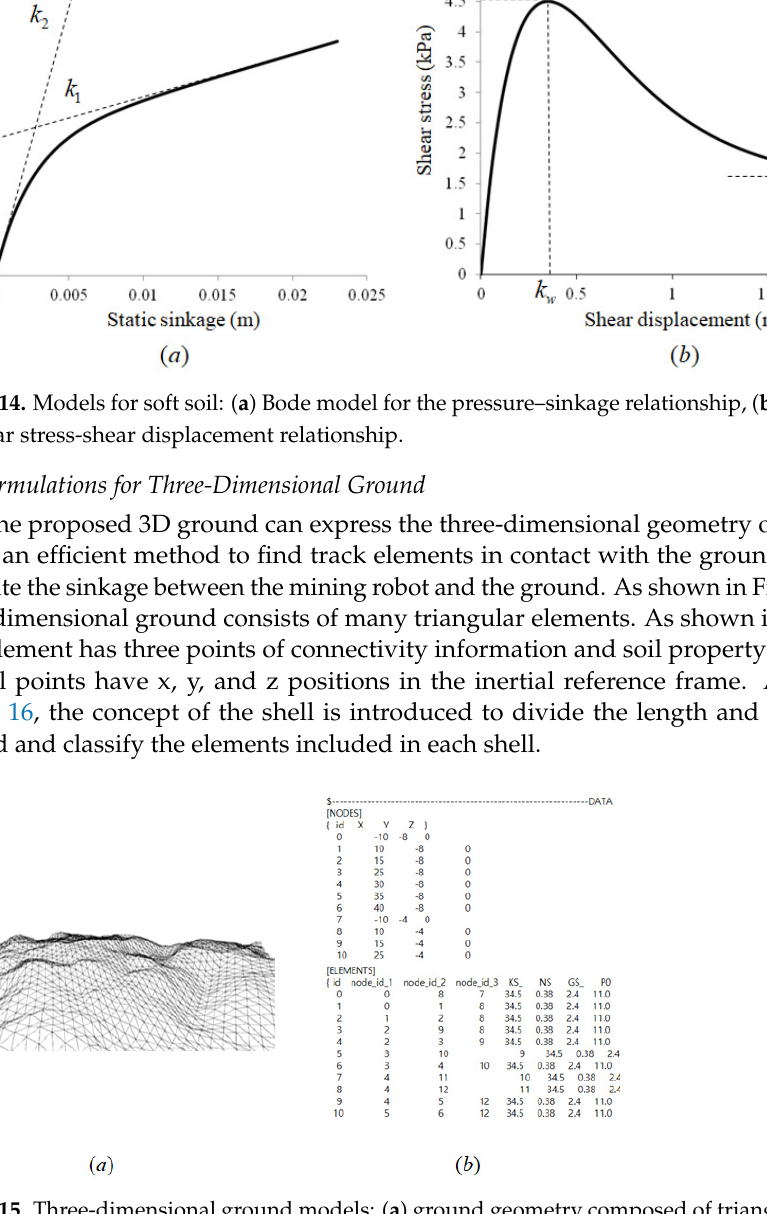
Figure 15. Three-dimensional ground models: ( a ) ground geometry composed of triangular elements, ( b ) configuration data (position information of nodes, information for connectivity of elements, and properties of soil) of the ground geometry.